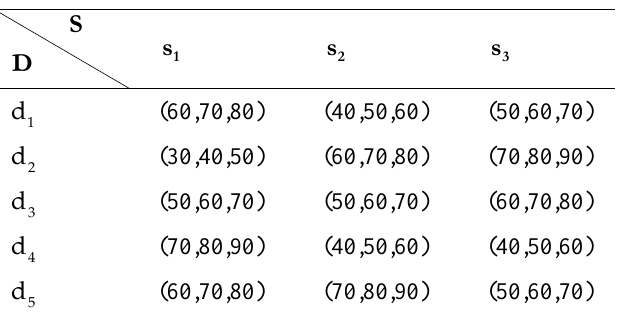
Table 1. Expert’s valuations in TFNs